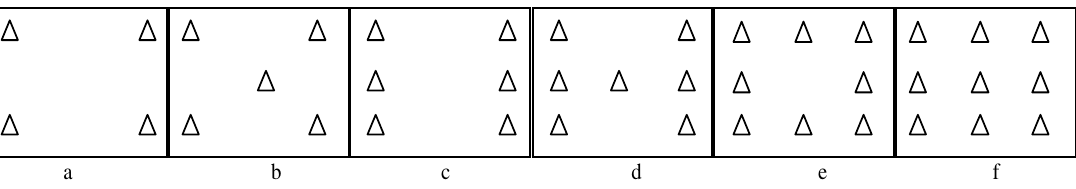
Figure 1. Ground Control Point Configurations for Photogrammetric Block (a) 4GCP, (b) 5GCP, (c) 6GCP, (d) 7GCP, (e) 8GCP, (f) 9GCP